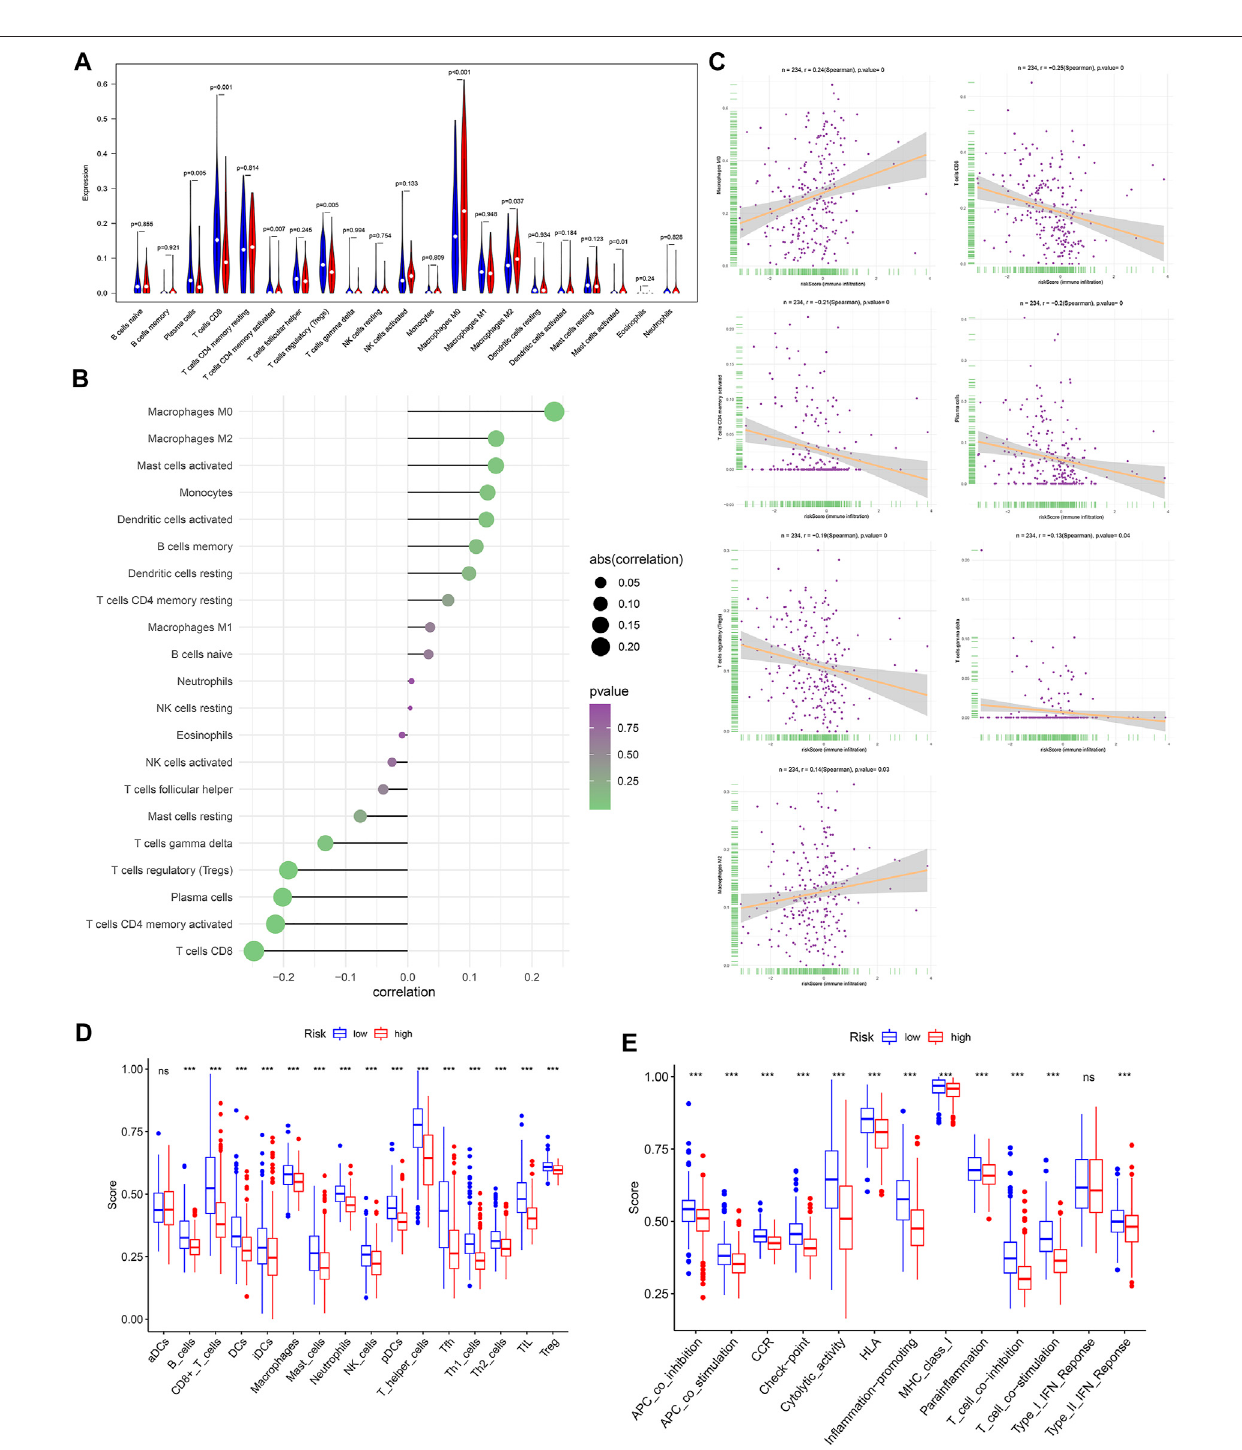
FIGURE 6 | The relationship between risk score and the tumor-in fi ltrating immune cells (TIICs). (A) Comparison of the TIICs between different risk groups. (B) The correlation of risk score and TIICs. (C) The associations between M0 macrophages, M2 macrophages, plasma cells, activated memory CD4 + T cells, CD8 + T cells, gamma delta T cells, regulatory T cells (Tregs), and risk score. Comparison of the single-sample gene-set enrichment analysis (ssGSEA) scores between different risk groups in TCGA cohort, including the scores of16 immune cells (D) and 13 immune-related functions (E) displayed in boxplots. CCR, cytokine – cytokine receptor. Adjusted p -values were shown as ns, not signi fi cant; * p < 0.05; ** p < 0.01; *** p < 0.001. In the high-risk group, N (cid:1) 267; in the low-risk group, N (cid:1) 244.